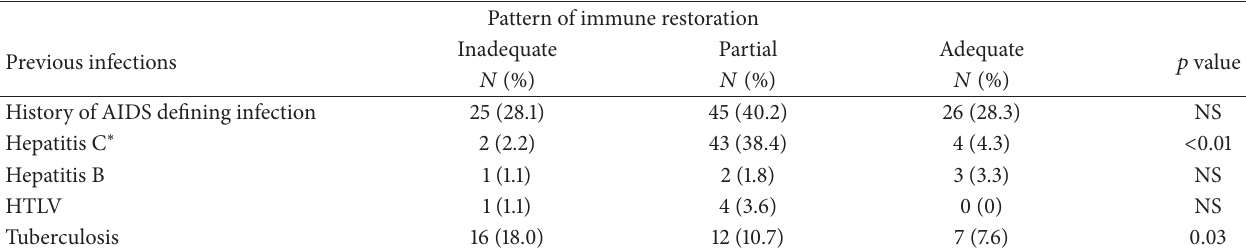
Table 2: Clinical and laboratory characteristics of patients according to degree of immune restoration. Pattern of immune